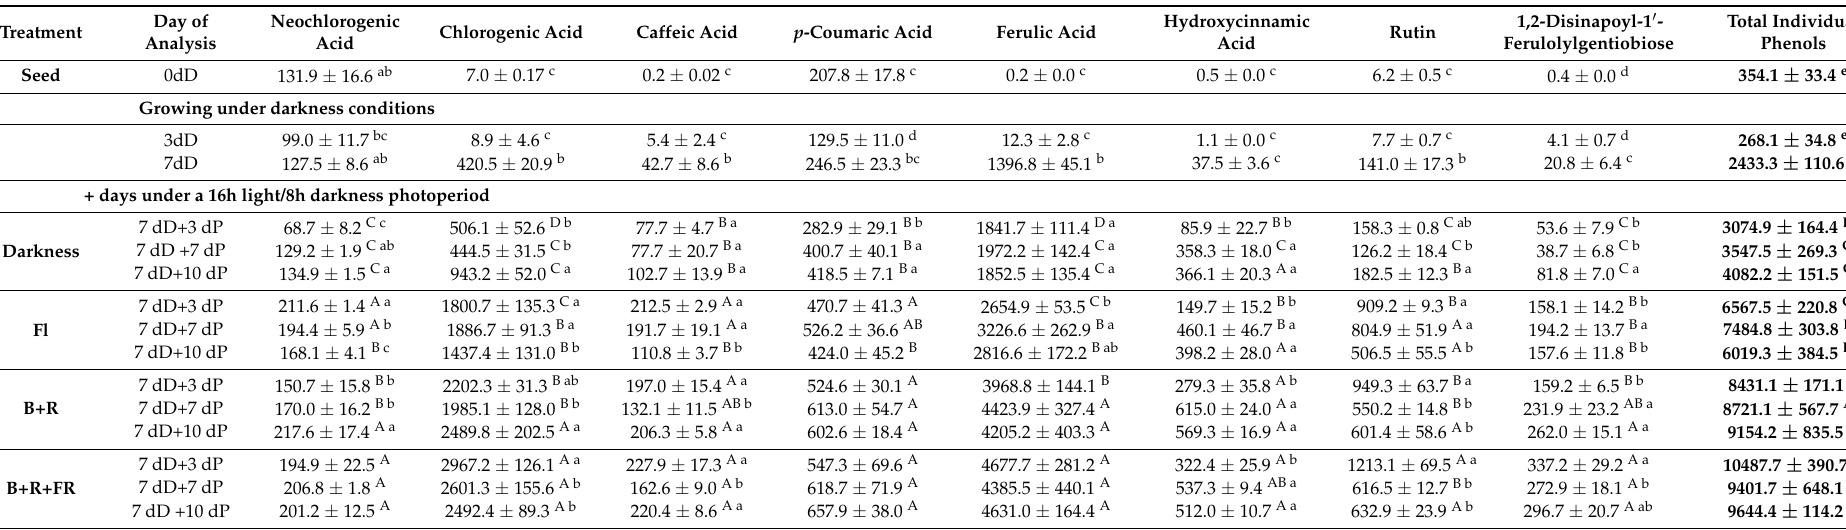
Table 3. Individual phenolic content (mg kg − 1 dw) of carrot sprouts grown at 20 ◦ C during 7 days in darkness (dD)+3 or 7 or 10 days of a 16 h/8 h photoperiod (dP) under several light